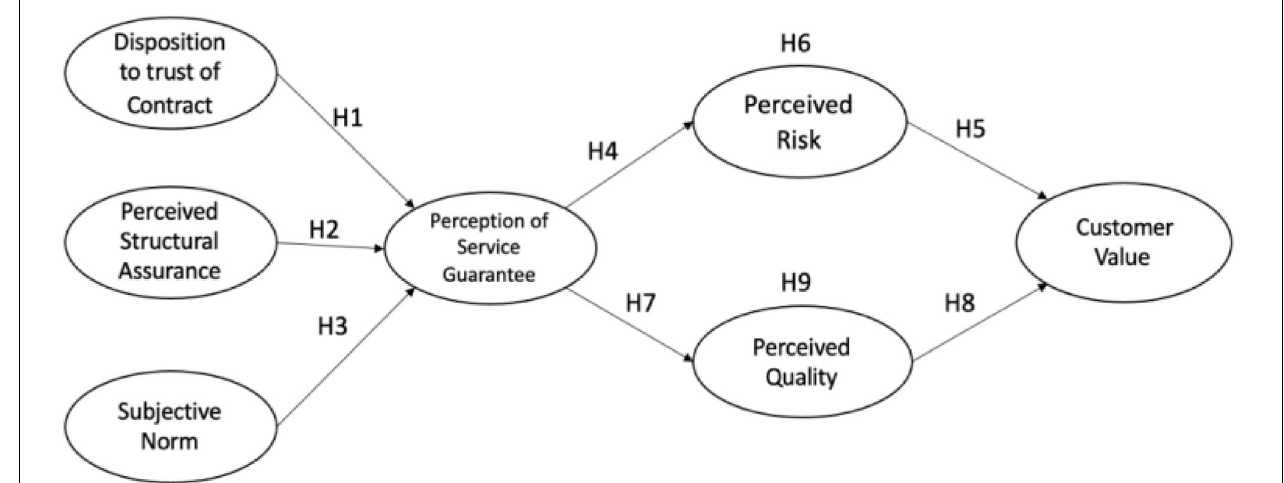
FIGURE 1 | Research